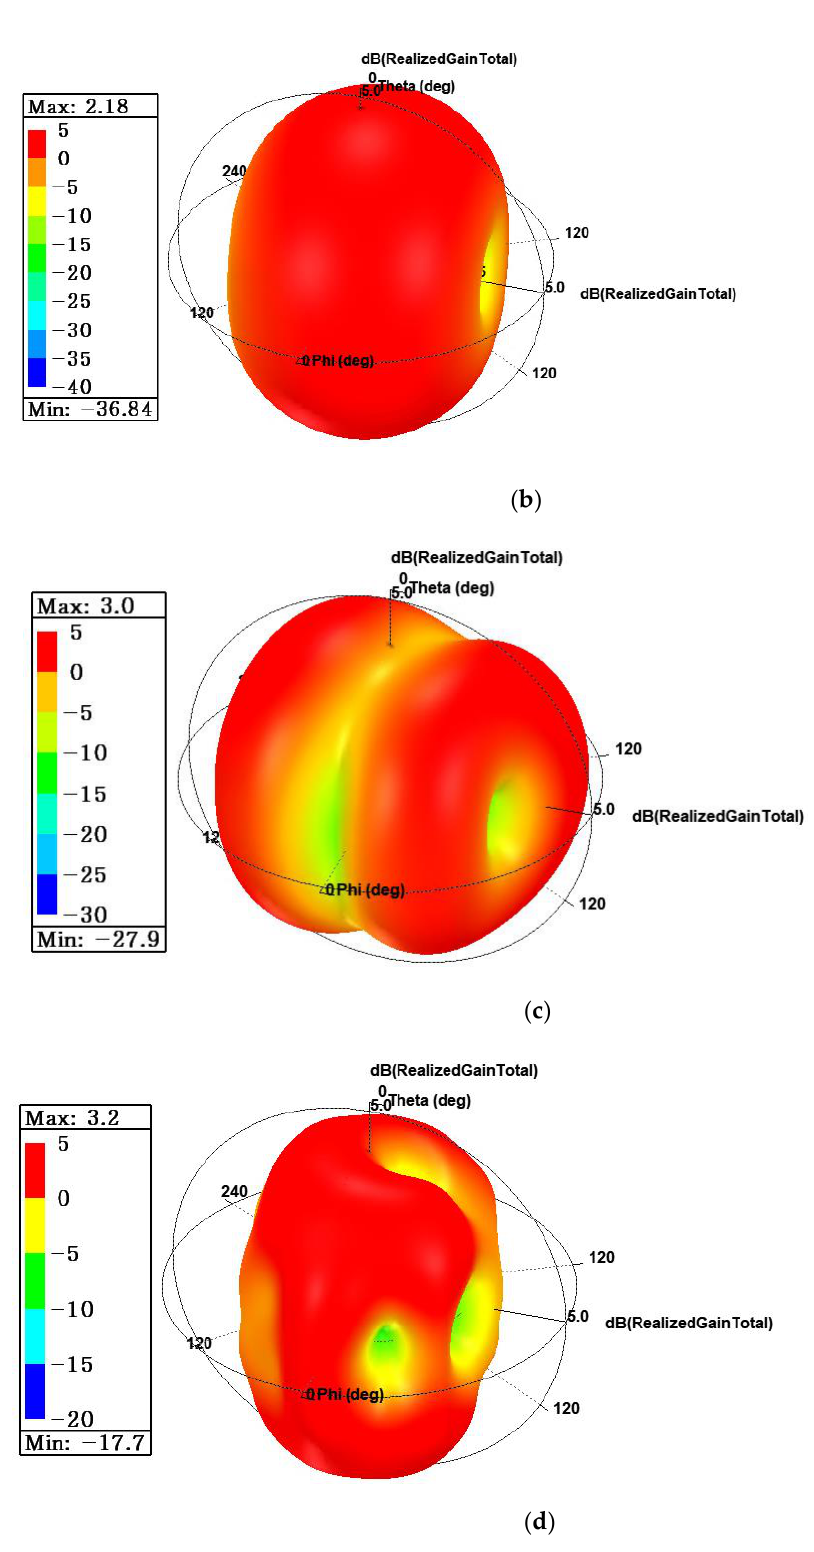
Figure 13. Simulated antenna 3D radiation pattern of the proposed antenna; ( a ) 3D radiation pattern at 2.4 GHz; ( b ) 3D radiation pattern at 3.5 GHz; ( c ) 3D radiation pattern at 6.3 GHz; ( d ) 3D radiation pattern at 10 GHz.